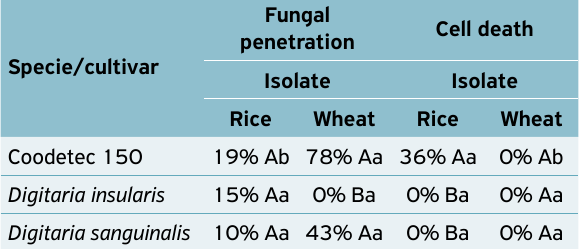
Averages followed by the same capital letter in the column or lowercase letter in the row do not differ among themselves by the Tukey test at 5%